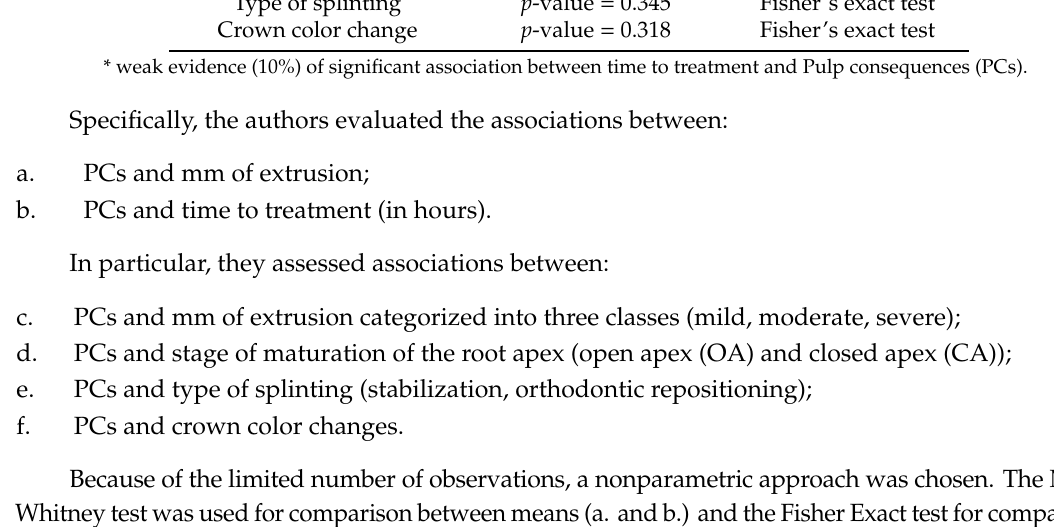
Table 1. The table shows associations between covariates and pulp consequences (PCO and PN). Covariate Association with PC’s Test Used mm of extrusion